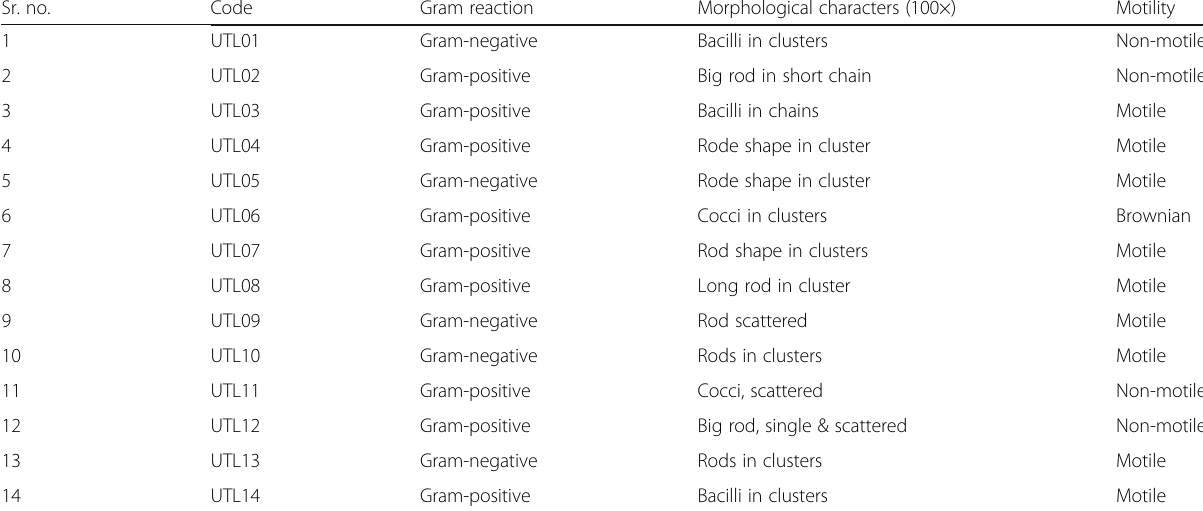
Table 3 Morphological characterization of isolates from unused leech under 100 × magnification Sr. no.